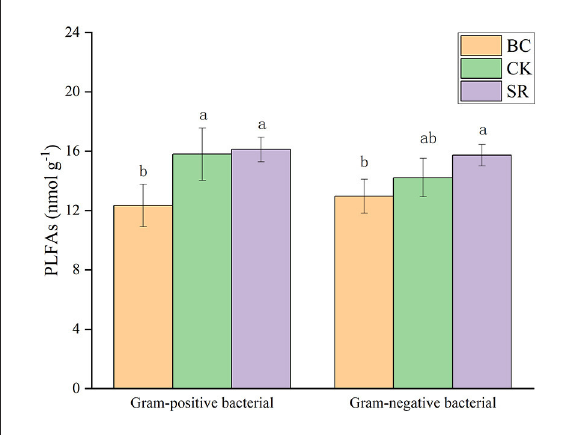
FIGURE3 Effect of maize straw and straw-derived biochar on gram-positive and gram-negative microbial PLFAs. The error bars represent the standard deviations of the mean values ( n = 3). Different lowercase letters indicate significant differences between the different treatments.